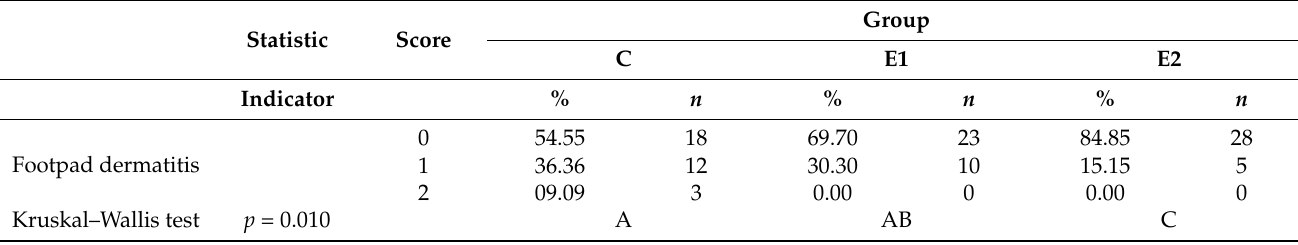
Table 2. Distribution of assessed animal-based welfare indicators (in percent) in the 3 groups, including significant differences ( n =